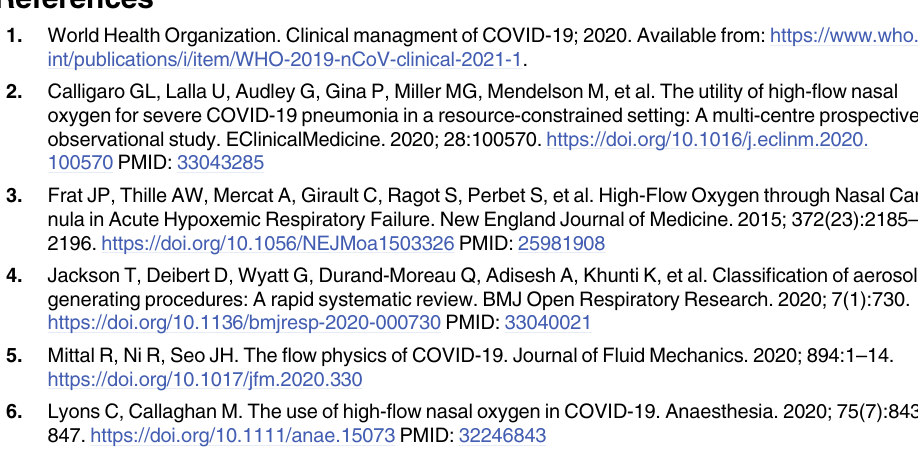
S1 Table. CFD simulations particle travel by diameter. Mean and maximum axial travel dis- tances at 6 s and 5 s for specified droplet diameter ranges in a range of breathing and coughing jet velocities,